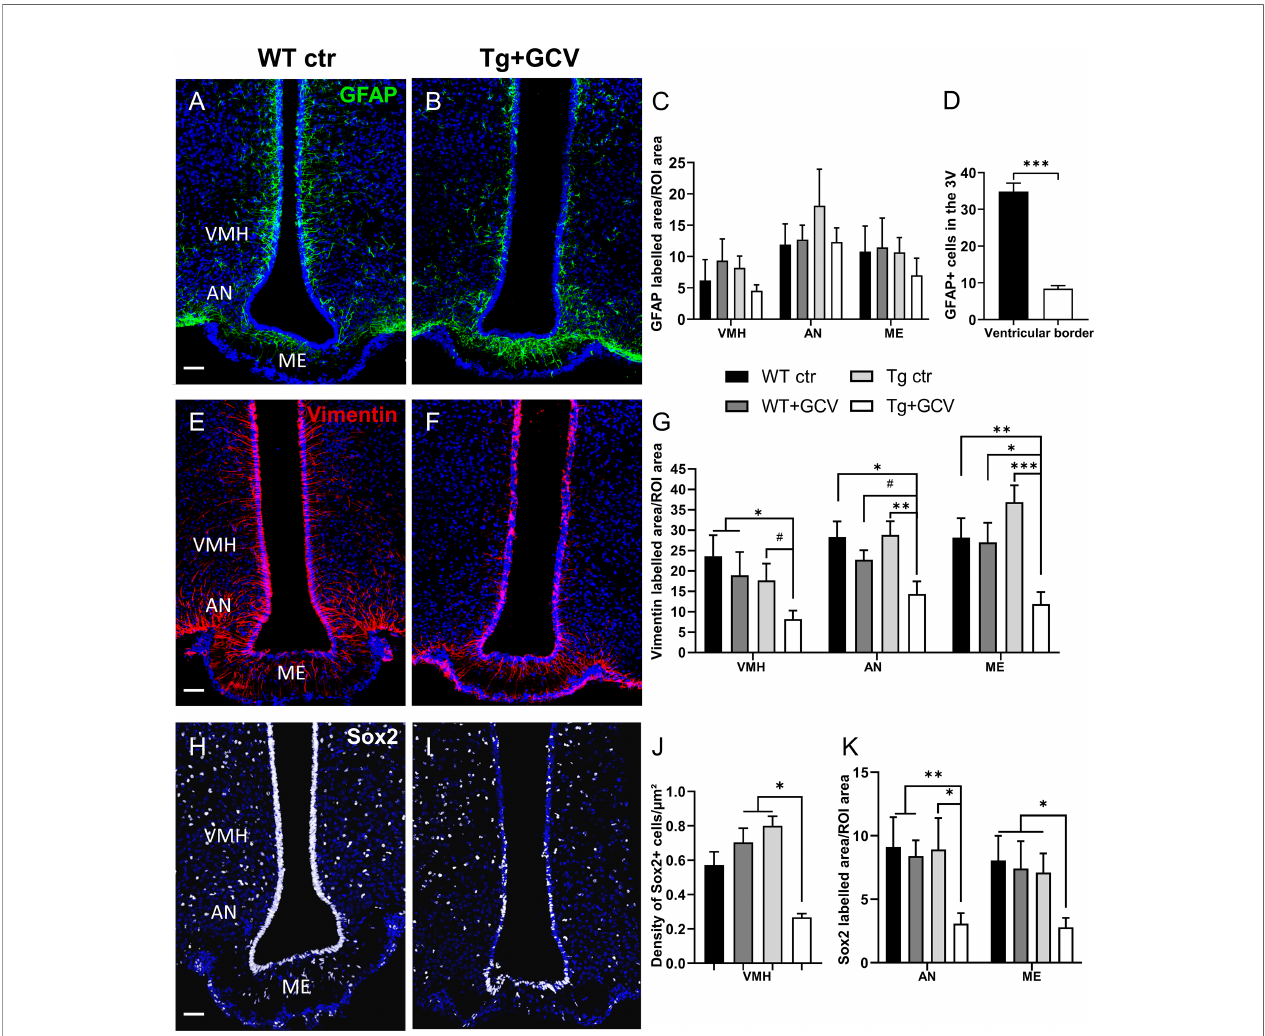
FIGURE 3 | In vivo central GCV administration in Tg mice impaired expression of NSPC markers within the MBH. Representative images of GFAP expression measured in the mediobasal hypothalamus of control (A) and Tg+GCV male mice (B) . Statistical analysis revealed no variation of GFAP expression in the VMH, AN and ME (C) . In contrast, the number of GFAP-positive tanycytes located in the ventricular border is statistically lower in Tg+GCV male mice as compared to control mice (D) . Confocal images of Vimentin expression in the mediobasal hypothalamus of control (E) and Tg+GCV male mice (F) . Tg+GCV male mice display a signi fi cantly decreased Vimentin expression in the VMH, NA and ME (G) . Representative images of Sox2 expression in the mediobasal hypothalamus of control (H) and Tg+GCV male mice (I) . Statistical analysis revealed signi fi cantly less Sox2 positive cells in the ventromedial hypothalamus (VMH) (J) , in the AN and in the ME (K) in Tg+GCV male mice. Data are expressed as the mean ± SEM, n ≥ 5 for each group. *p<0.05, **p<0.01. ***p<0.001, # p=0.06 or 0.07. Scale bars, 50